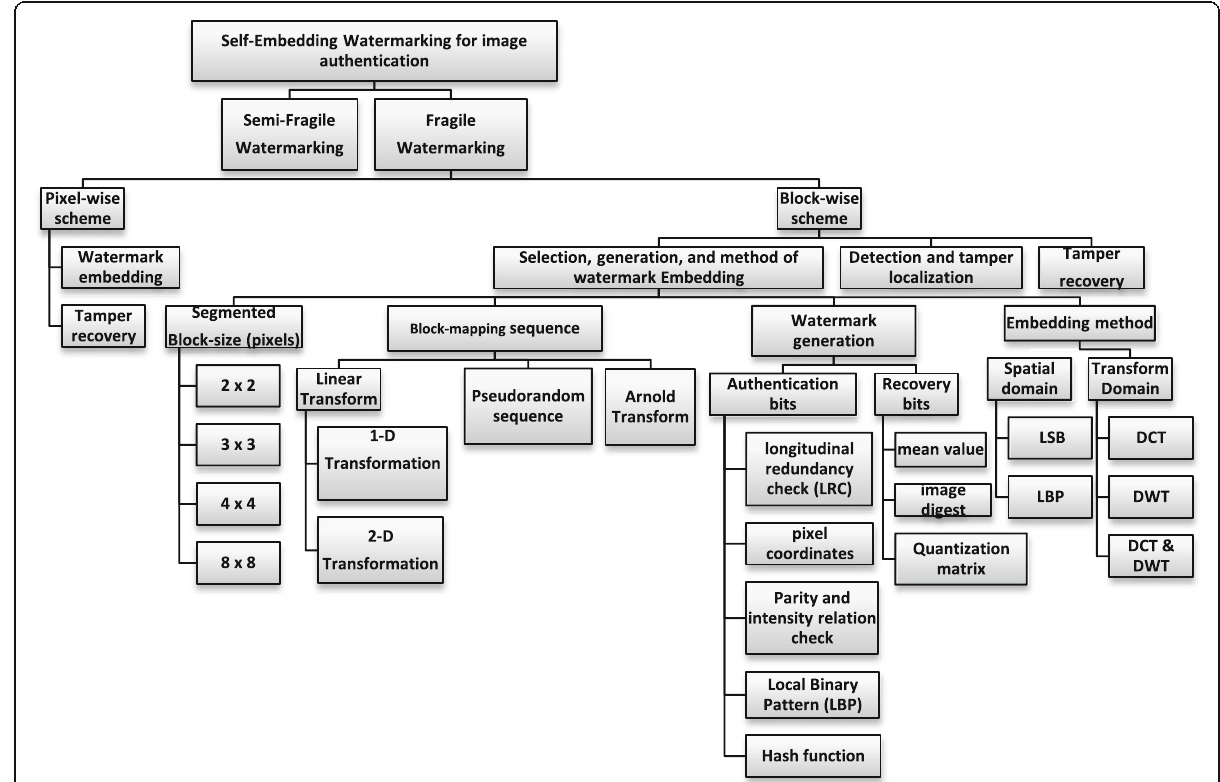
Fig. 1 A brief overview of self-embedding watermarking for image